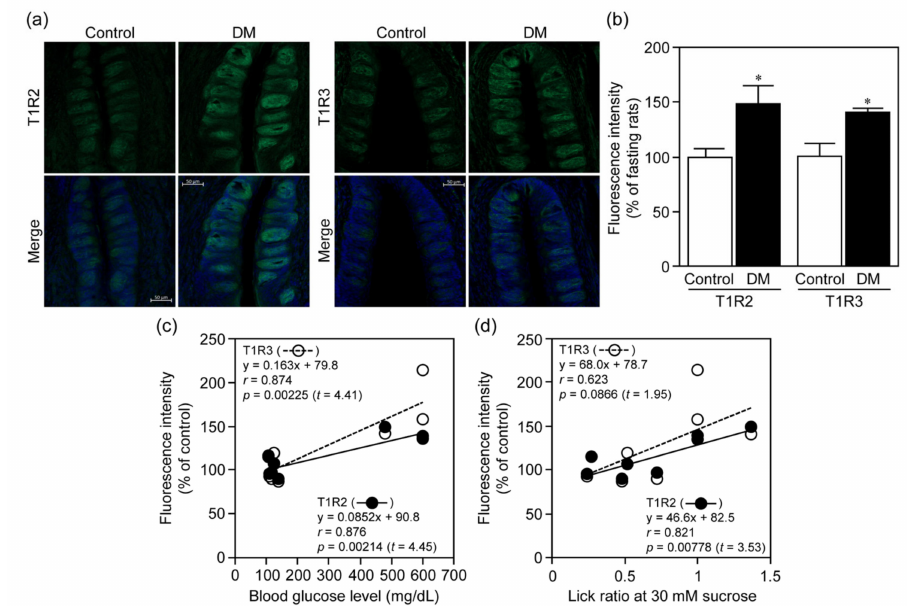
Figure 5. Protein expression of sweet taste receptors in CP of STZ-induced DM rats. The expression levels of T1R2 and T1R3 in CP isolated from the tongues of rats on day 35 were determined by immunohistochemical analysis. In panel a , green and blue signals indicate expression of T1R2 or T1R3 and nuclei, respectively, and the results for fluorescence intensity derived from the immunoreactivity of T1R2 and T1R3 are given in panel b . In panel a , we linearly adjusted the contrast of whole images including background by changing the input value from 255 to 150 in the images for T1R2 and T1R3 in control and DM groups. Bar = 50 µ m. Each bar represents the mean ± SD for 5 (control) or 3 (STZ) rats. * p < 0.01 (vs. control). Panels c and d indicate correlation between blood glucose levels and expression levels of T1R2 or T1R3 on Day 35, and between lick ratios at 30 mM sucrose on Day 17 and expression levels of T1R2 or T1R3 on Day 35, respectively, in